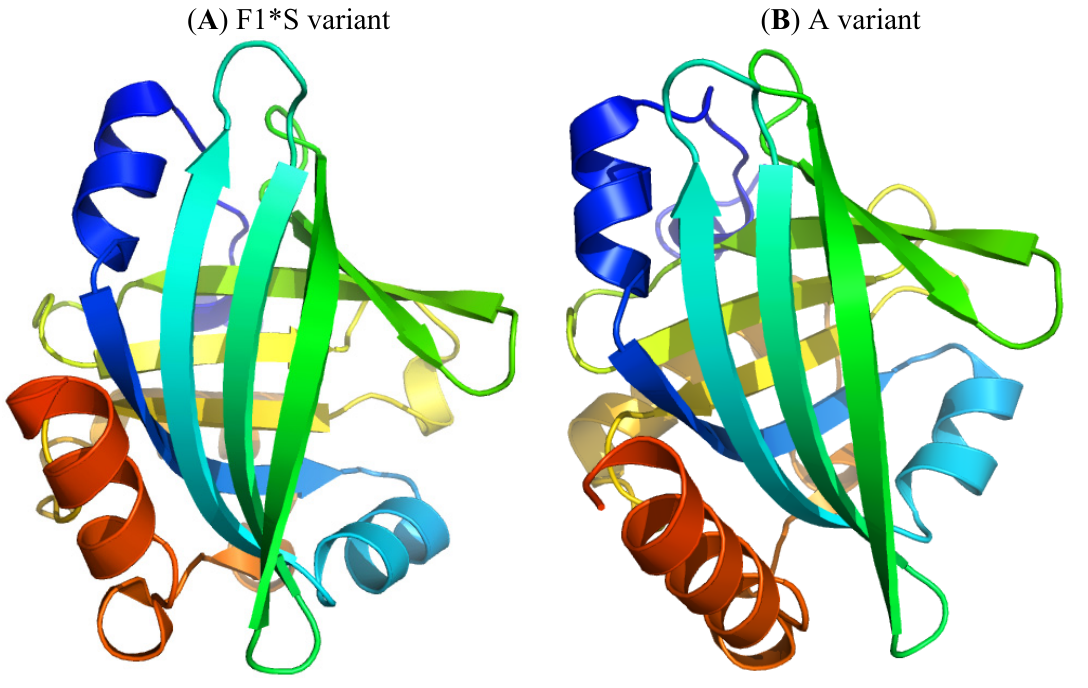
Figure 5. Crystal structures of the human AGP F1*S ( A ) and A variants ( B ). Both illustrations were produced by PyMol using the atomic coordinates from the Protein Data Bank, 3KQ0 for (A) [37] and 3APX for